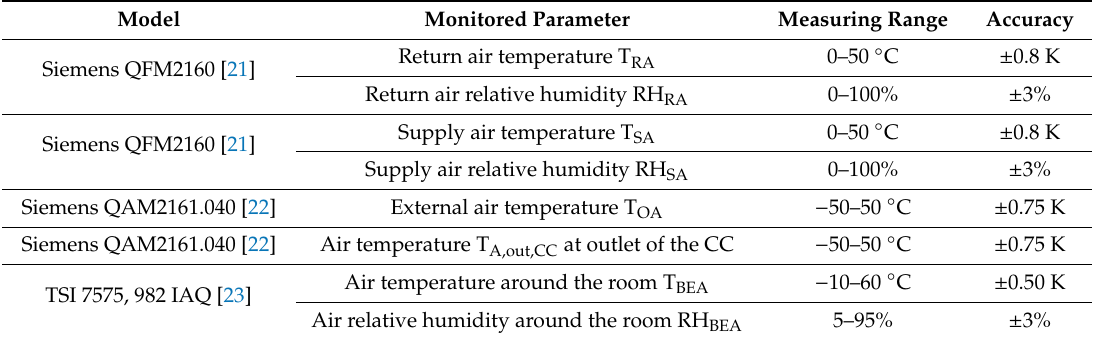
Table 3. Characteristics of the sensors used for the AHU monitoring.